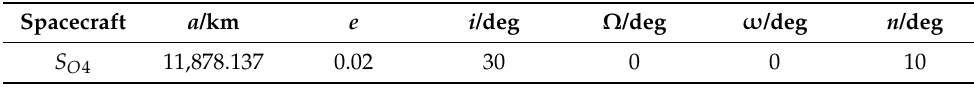
Table 7. Nominal orbital elements for observability analysis.